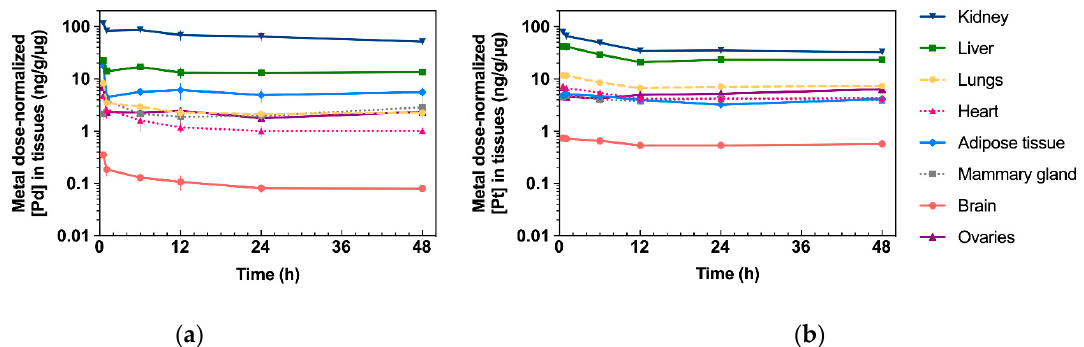
Figure A1. Kinetic profiles of Pd (from Pd2Spm, 3 mg/kg bw) and Pt (from cisplatin, 3.5 mg/kg bw) in tissues after single intraperitoneal bolus injection in Balb/c mice. Data are expressed as mean ± SEM (n = 5 animals per time point). Units: h.ng/g of tissue ( a ) Concentration–time plot of mean Pd levels in tissues. ( b ) Concen-tration–time plot of mean Pt levels in tissues.